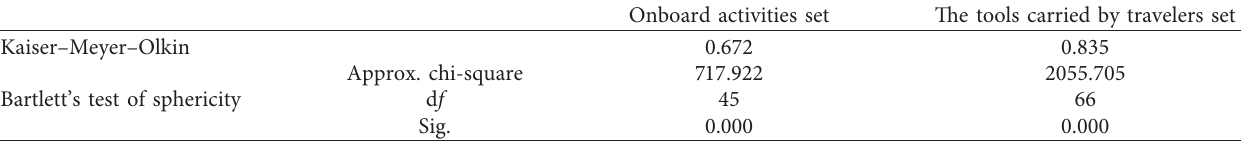
Table 6: KMO and Bartlett’s